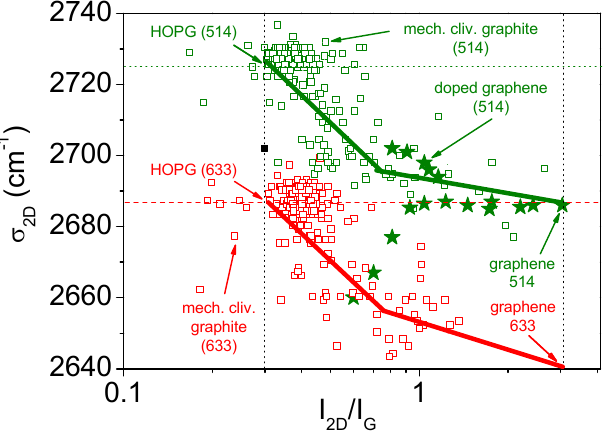
Figure 11. 2D band position as function of I 2D / I G for laser wavelengths of 514 and 633 nm. Graphene frequencies were obtained from [1]. Empty squares are from mechanically cleaved graphene flakes (original data). Stars are from [160] (doped with carrier density from − 3 × 10 13 cm − 2 to +4 × 10 13 cm − 2 ), the downshift corresponds to positive doping, whereas upshift corresponds to negative doping.